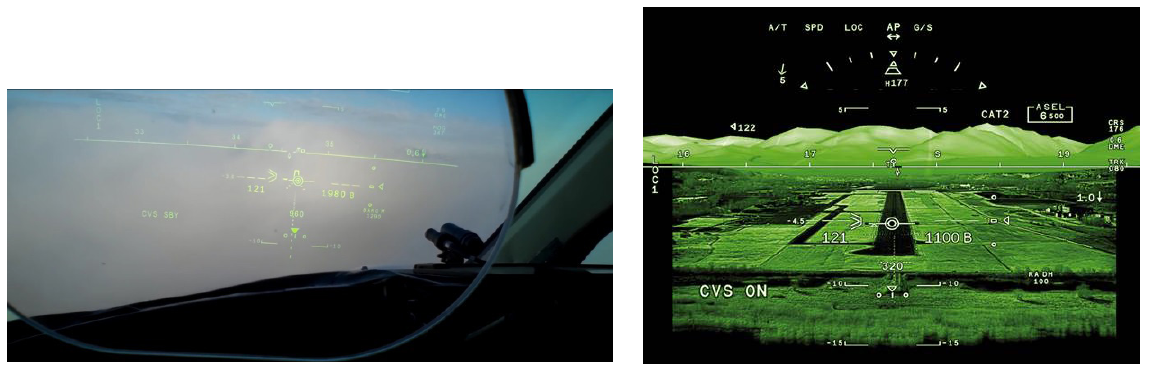
Figure 3. Dassault Falcon Eye CVS (promotional video at